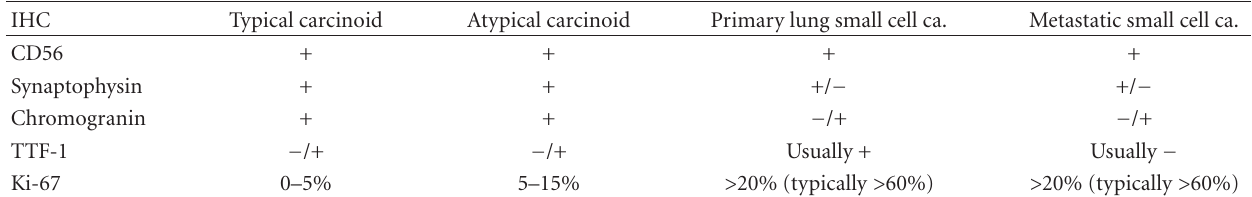
Table 2: Immunohistochemical profile of neuroendocrine